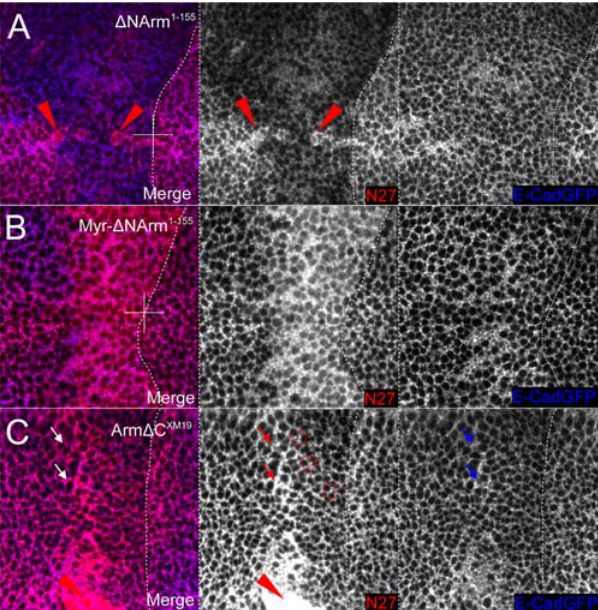
Figure 10. E-Cadherin levels change in the AJ in response to changes in levels of endogenous Armadillo protein upon N- terminal deletion mutant overexpression. (A) Overexpression of the D NArm 1–155 construct with dppGAL4 causes a reduction in E- Cadherin levels concomitant with a decrease in endogenous Armadillo (blue arrows). (B) No change is evident in E-Cadherin levels when the membrane tethered Myr- D NArm 1–155 form is overexpressed. (C) Although levels of endogenous Armadillo increase at the level of the AJ upon overexpression of Arm D C XM19 (red arrows), there is no change in levels of E-Cadherin relative to the wild type (blue